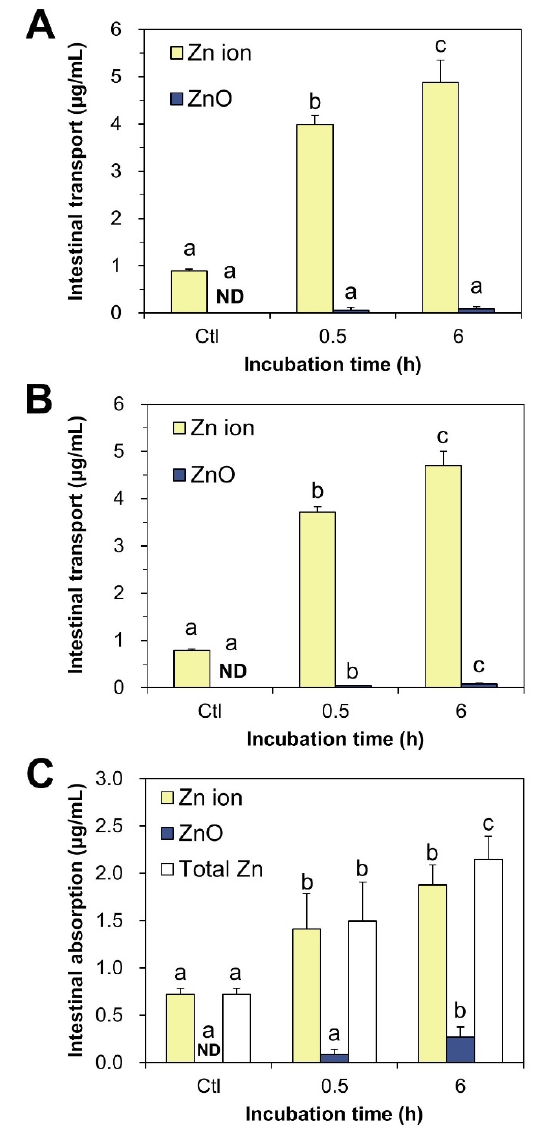
Figure 7. Intestinal transport fate of ZnO NPs obtained from in vitro models of ( A ) Caco-2 monolayer and ( B ) follicle-associated epithelium (FAE) by CPE. ( C ) Intestinal absorption fate of ZnO NPs using ex vivo everted small intestine sacs. Different lower-case letters (a,b,c) indicate significant differences among different incubation times ( p < 0.05). Abbreviation: ND, not detectable.